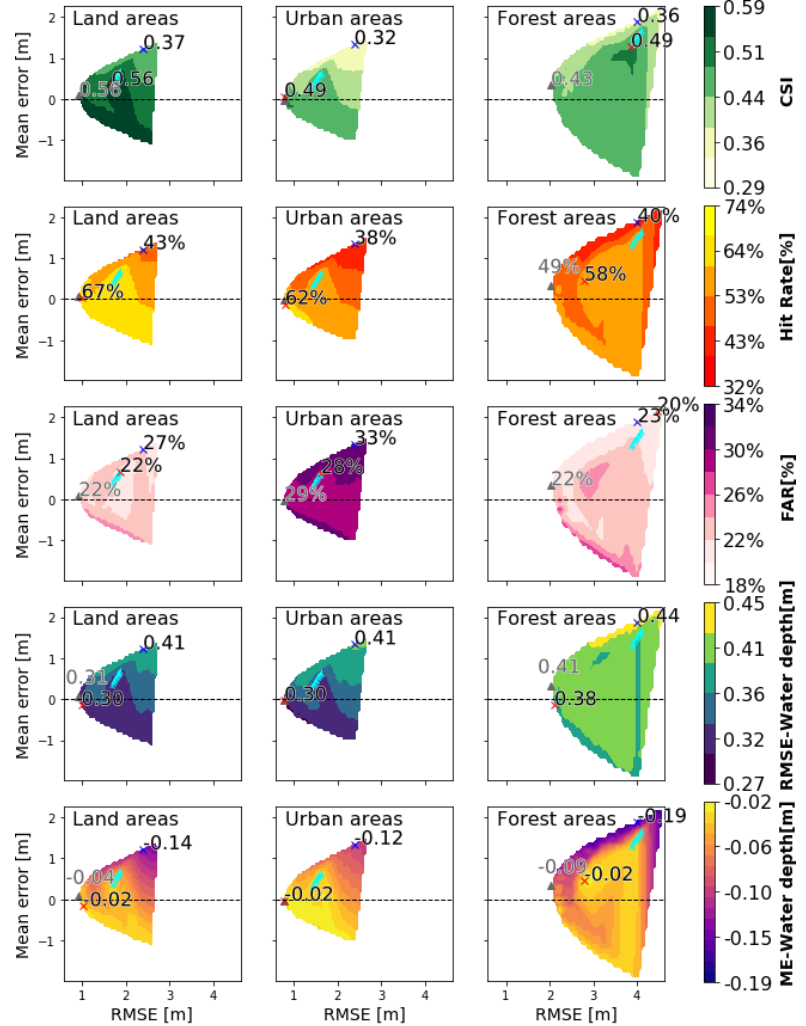
Figure 6. Surface plot of the CSI score, hit rate, FAR, the water depth RMSE, and mean error (ME) simulated using the ArcticDEM-SMRF realizations (ArcticDEM filtered using the 234 SMRF parameter combinations) at sample S3 plotted against the RMSE and the mean error in each realization member. The locations of the highest CSI and hit rate, the smallest FAR, RMSE, and the smallest absolute value of mean water depth error are marked as red crosses, with the values displayed. The location of the lowest RMSE of the ArcticDEM-SMRF are marked as triangles, with values displayed (values are not shown if both the location and value are close enough as the best flood inundation metric value). In addition, the RMSE and mean error in the original ArcticDEM are located and marked as blue crosses in each panel with the five-metric value of the original ArcticDEM simulation displayed. The locations of ArcticDEM-SMRF filtered with window size = 10m are marked with symbols in cyan